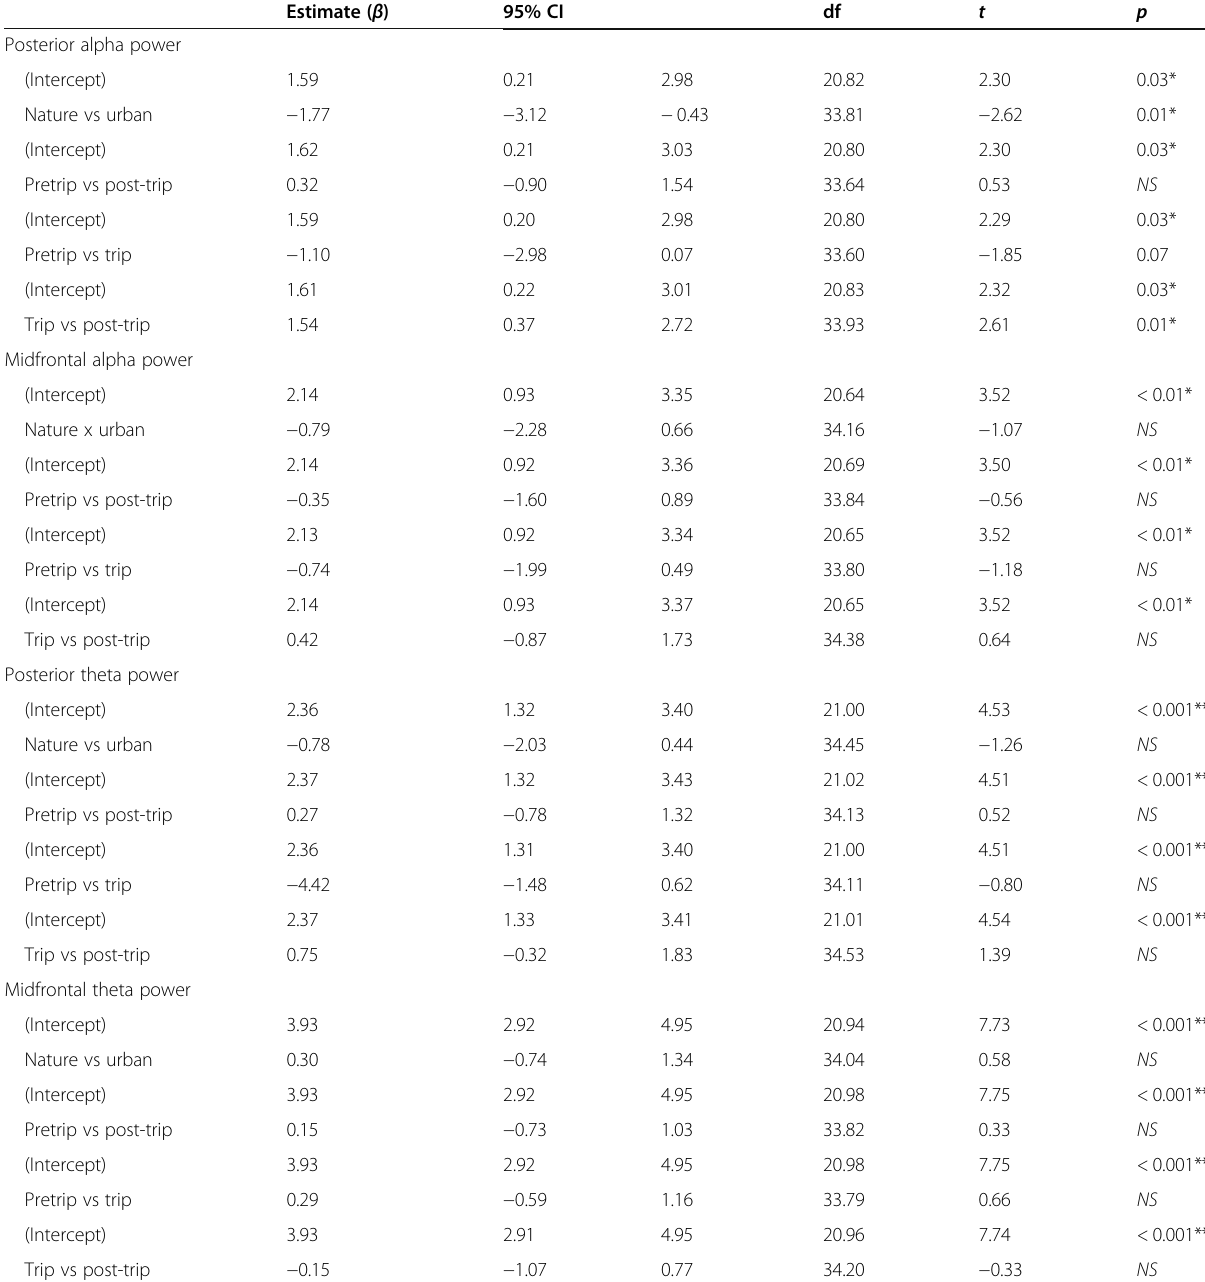
Table 2 Regression coefficients for session comparisons regressed onto electrode sites for power collected during eyes-opened rest Estimate ( β ) 95% CI